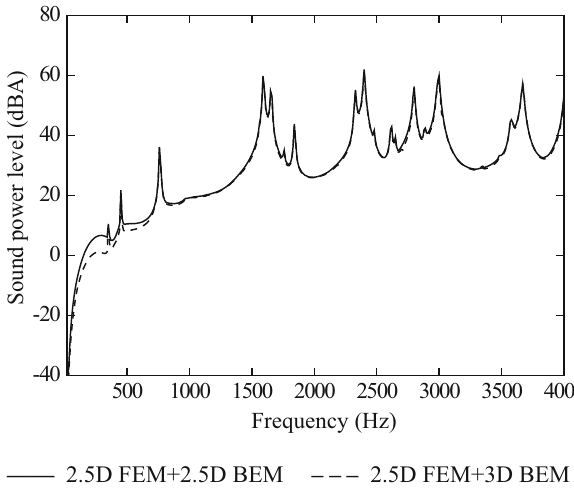
Fig. 9 Comparison of the radiated sound power